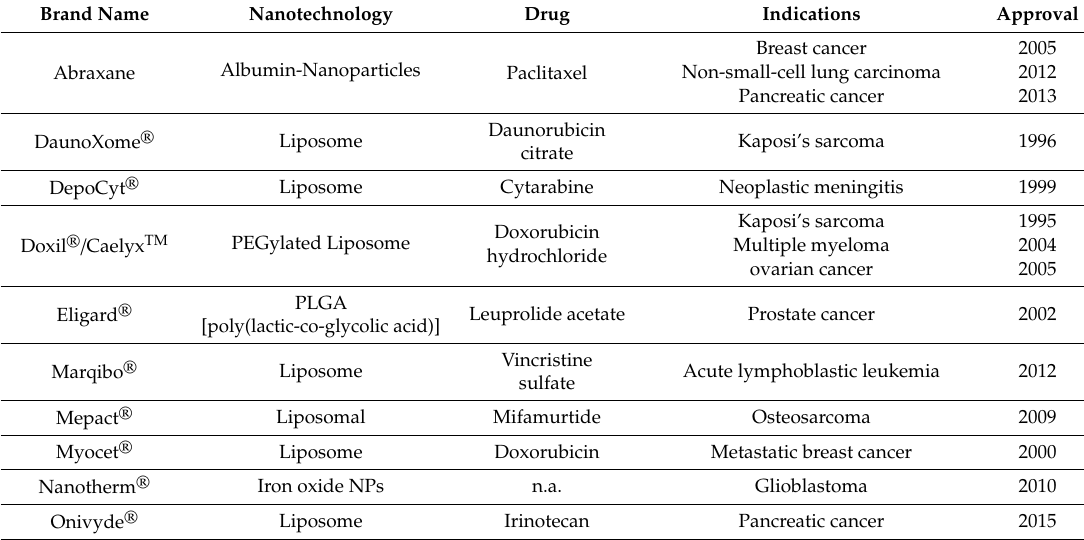
Table 1. FDA and European Medicines Agency (EMA)-approved nano-based formulations for cancer related therapy (ref: ema.europa.eu; drugs.com;